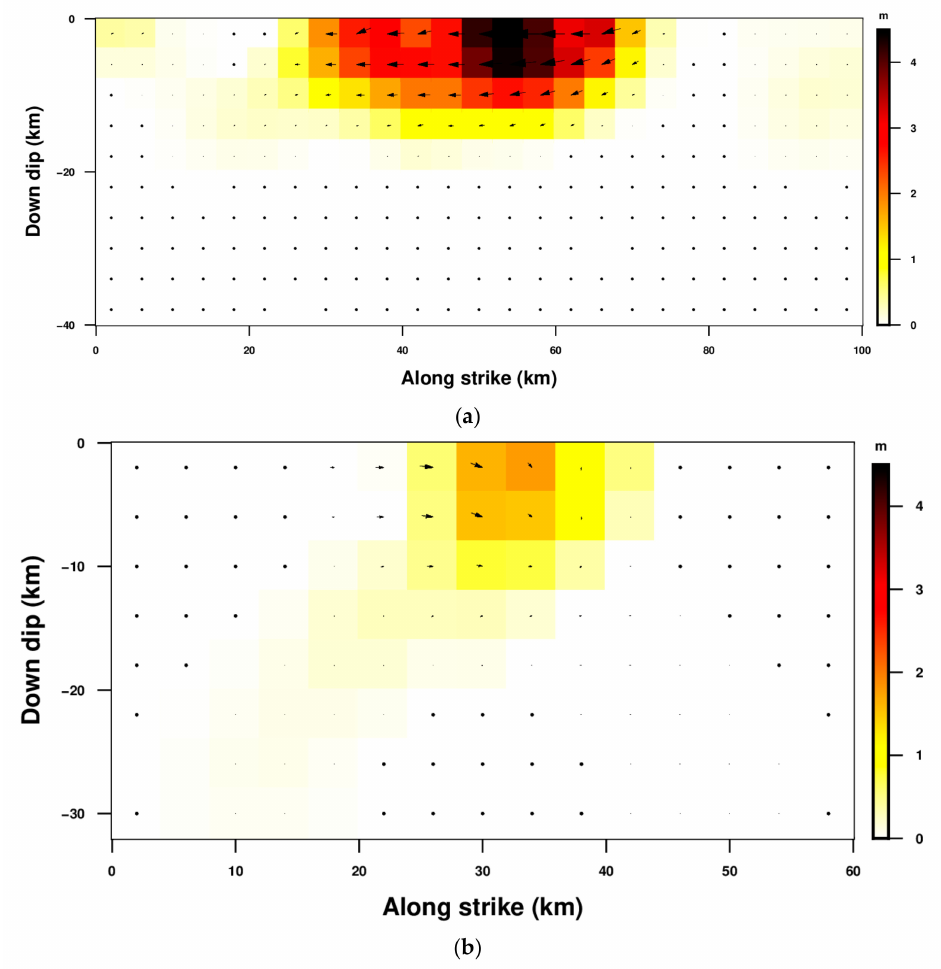
Figure 9. Two-dimensional optimal slip distributions of ( a ) F1 and ( b ) F2. The heading of the black arrows indicates the slip vectors of each